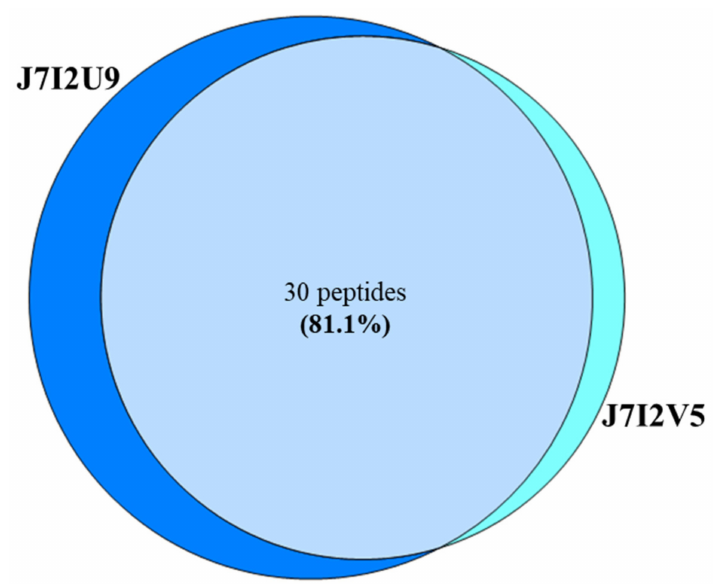
Figure 5. Venn diagram representing the distribution of the tryptic peptides shared between the J7IU9 and J7I2V5 isoforms of β